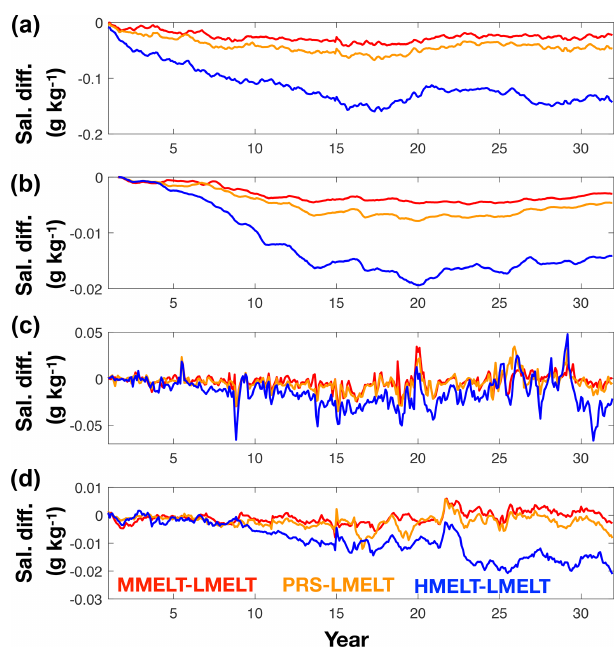
Figure 8. Time series of spatially averaged salinity difference over (a) RS continental shelf at 200m depth, (b) deep RS bottom, (c) continental shelf off CD at 200m depth, and (d) WS conti- nental shelf at 200m depth. Spatial averages have been calculated for the regions indicated in Fig. 1 but using regions shallower than 1000m and deeper than 2500m for on-shelf 200m spatially aver- aged and bottom spatially averaged salinity, respectively (Table 4). LMELT fields are subtracted from HMELT (blue), PRS (orange), and MMELT (red) fields to calculate the